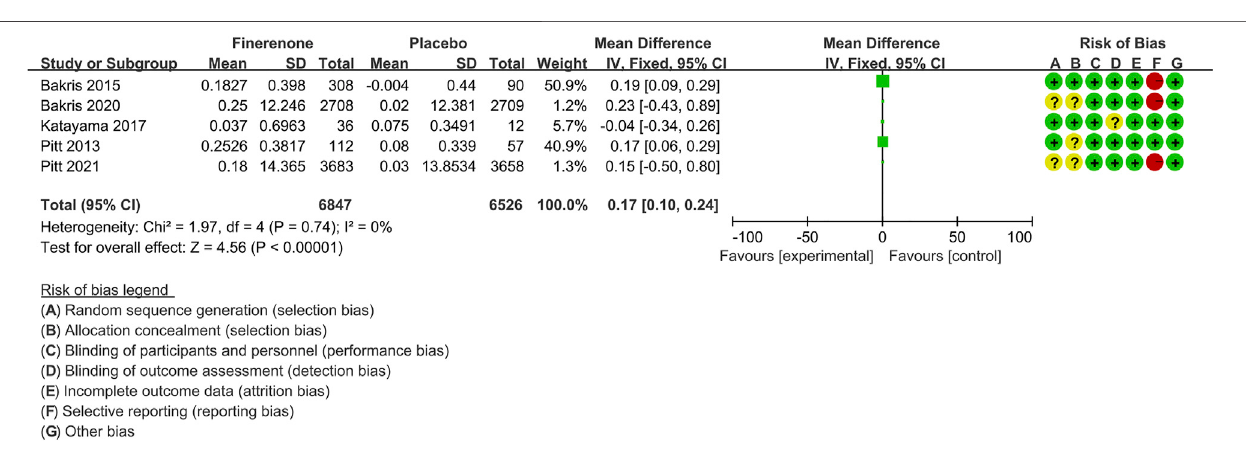
FIGURE 8 | Meta-analysis results of changes in serum potassium concentration between fi nerenone and placebo patient groups.